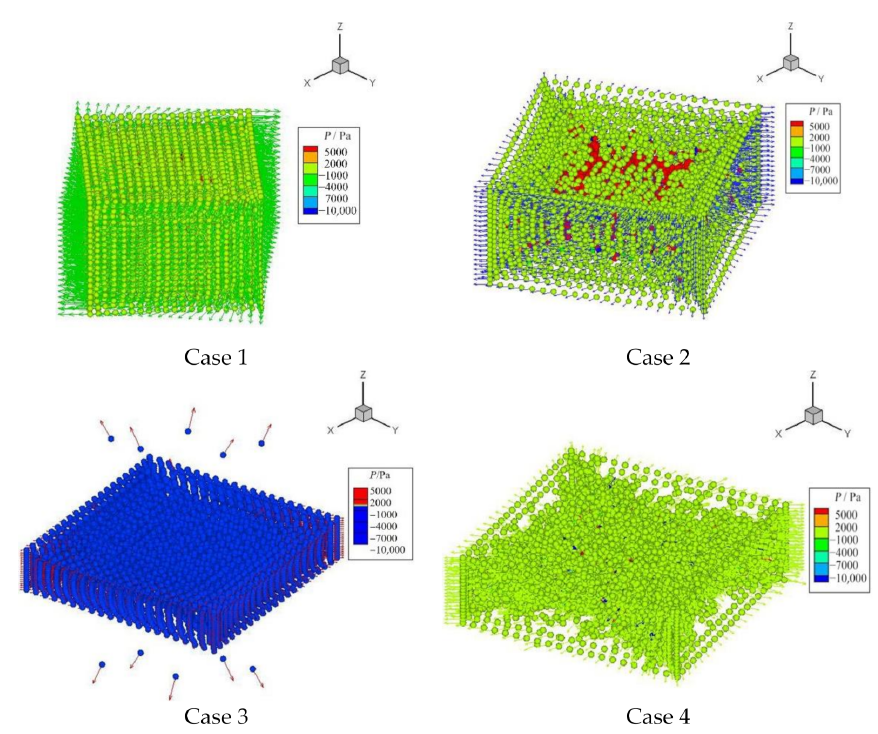
Figure 8. Deforming states at the end of computation for four cases (shown with the particles and their velocity